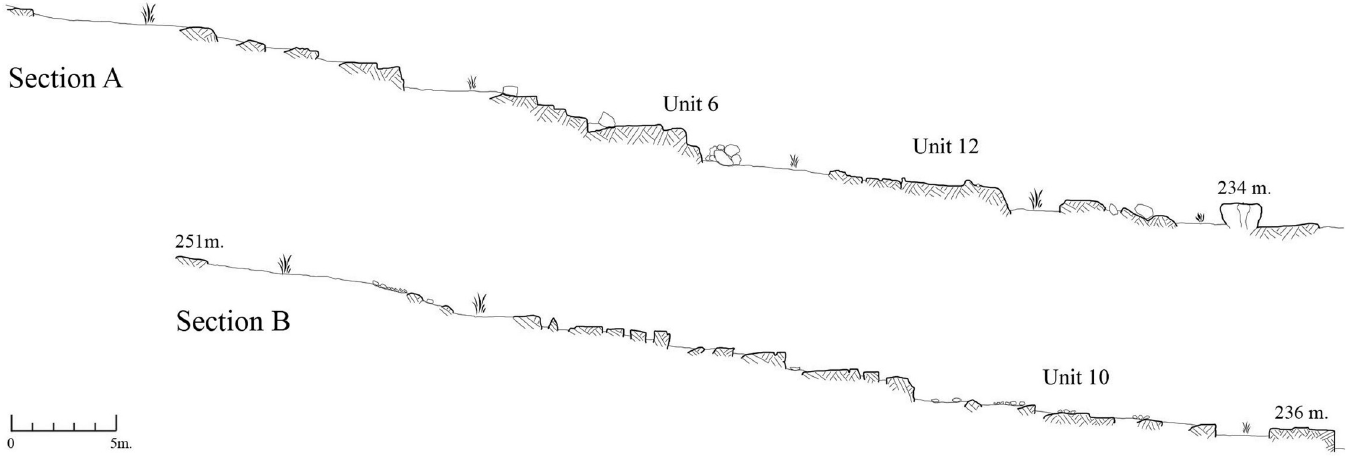
Fig 14. The two transects along the slopes of the hill (A,